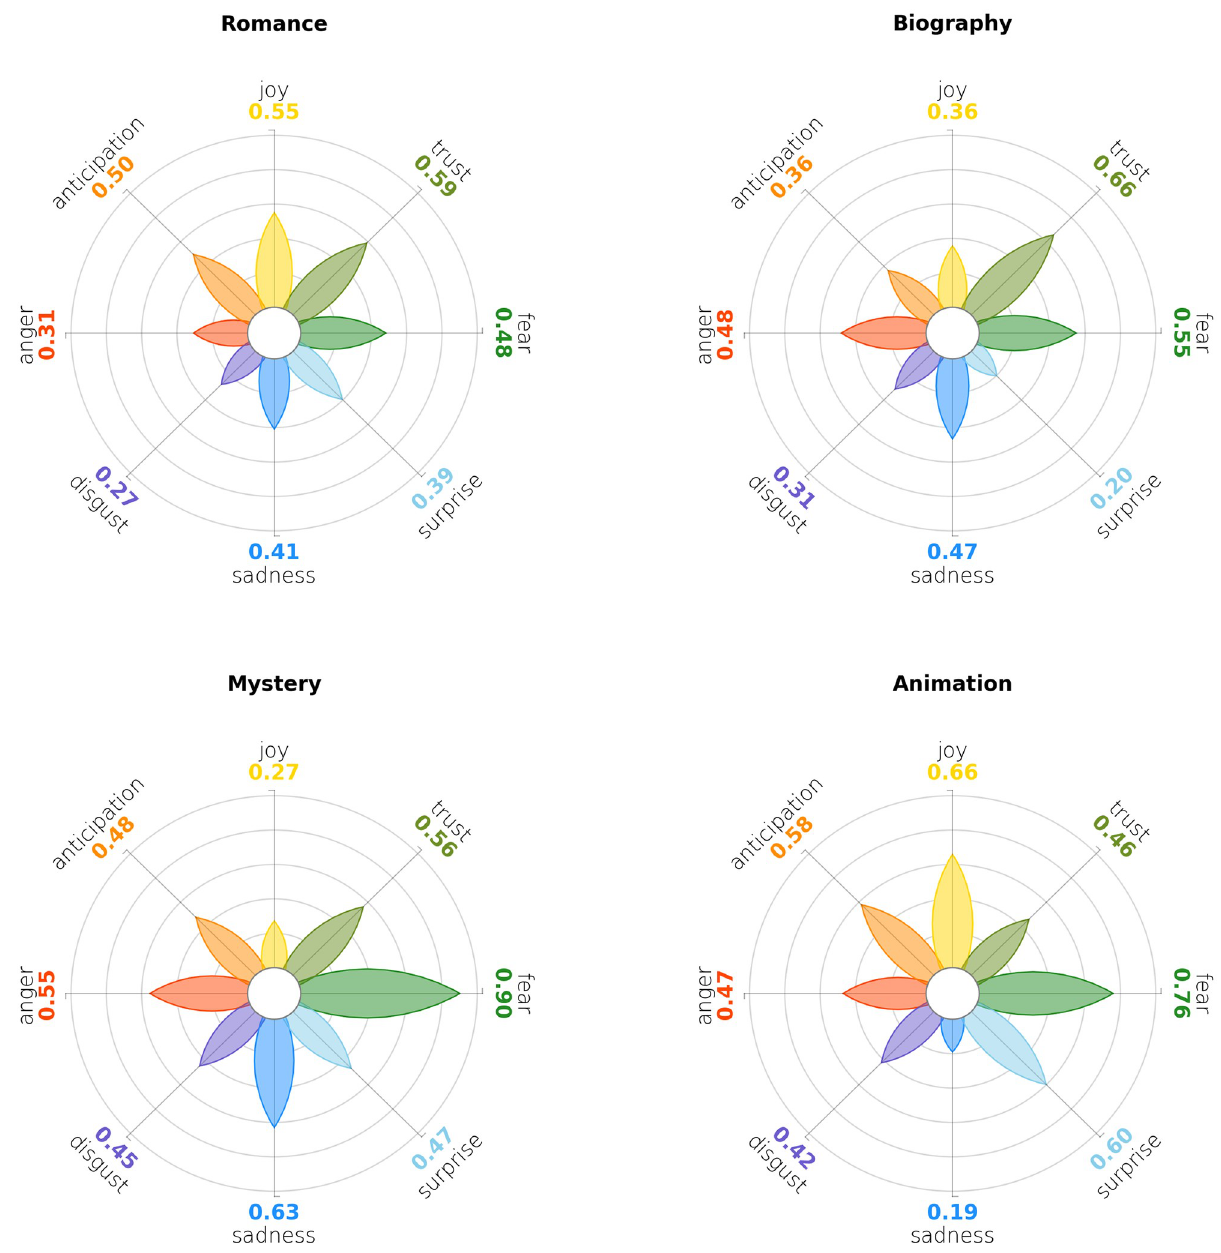
Fig 12. Emotions in the synopses of the top 1000 movies in the IMDB database, divided by four genres. The shapes are immediately distinct from each other, and they return an intuitive graphical representation of each genre’s peculiarities.